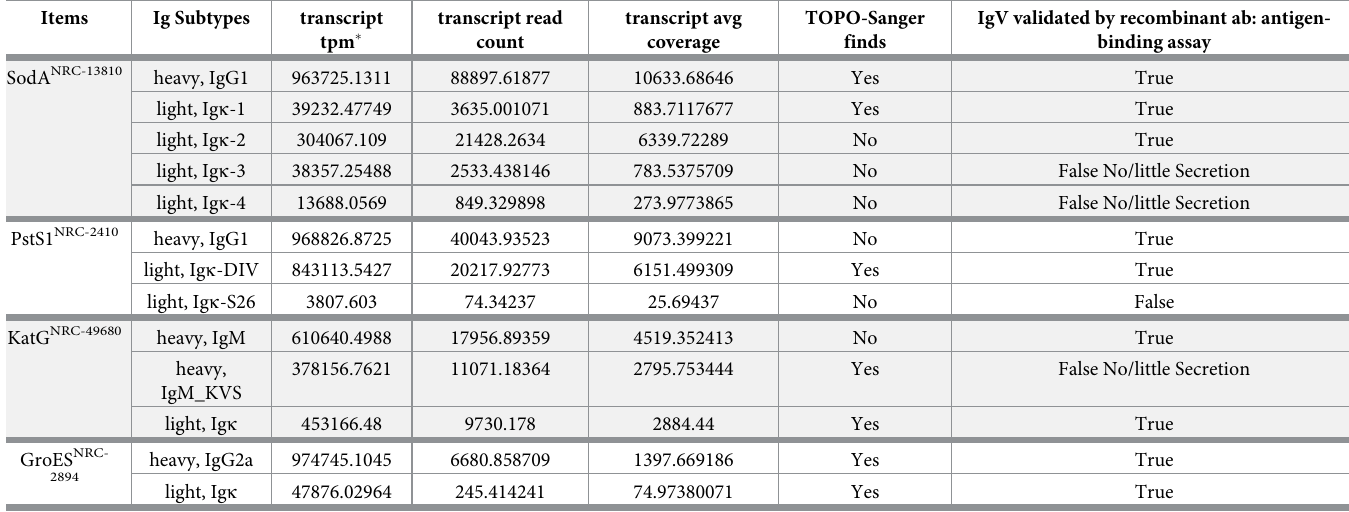
Table 2. IgV sequences identified by NGS/bioinformatics and Sanger sequencing methods.